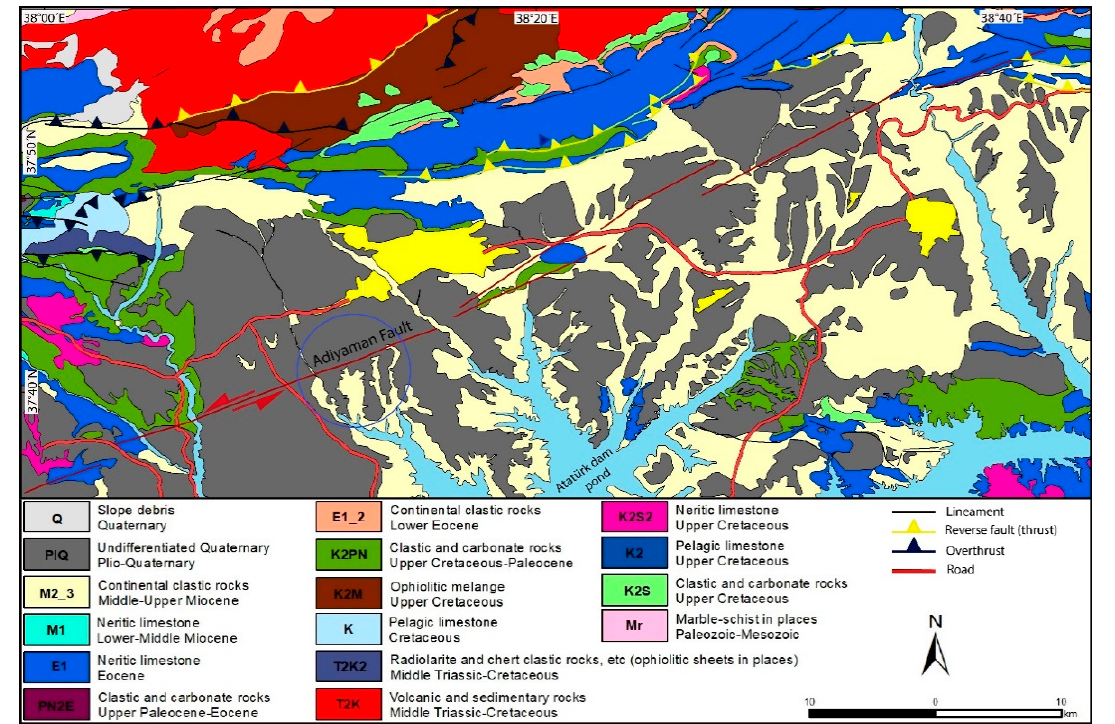
Figure 8. Refined lithological and structural map obtained in this study. Blue circle indicates the region where offset river channels are revealed by the new map. Note the difference between the two maps; in the new map, formation contacts are refined, and some outcrops are found to be missing in the published geology map. Areas of settlements are defined by yellow polygons.